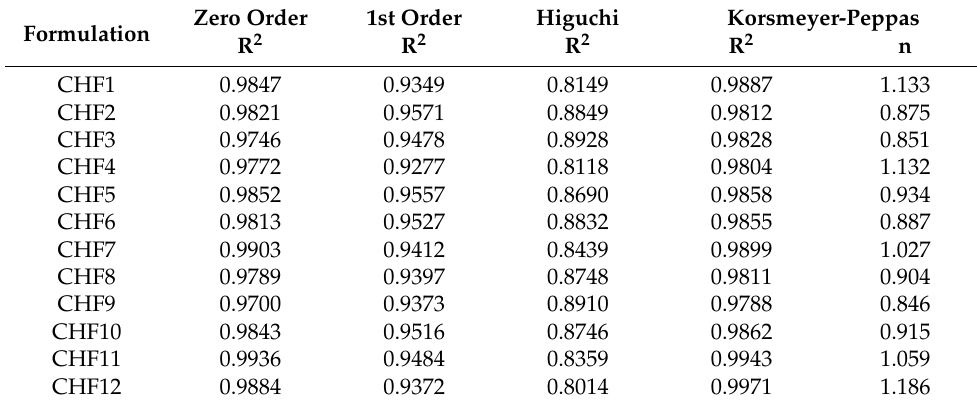
Table 2. Results of kinetic modeling on CAP release profile.